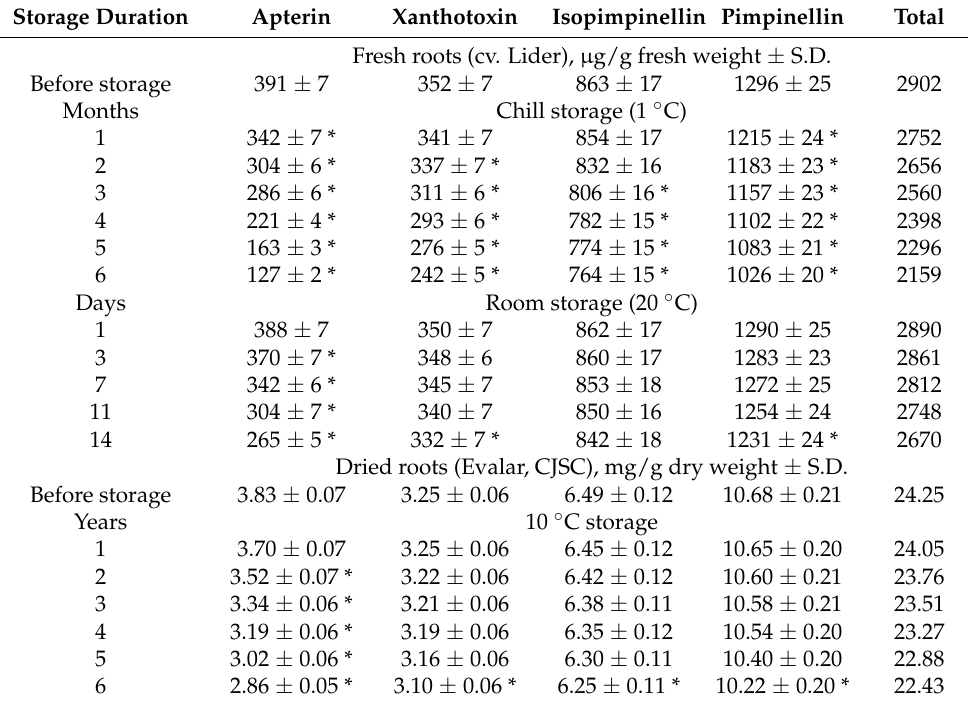
Table 5. Content of four coumarins in fresh and dried lovage roots during post-harvest storage.